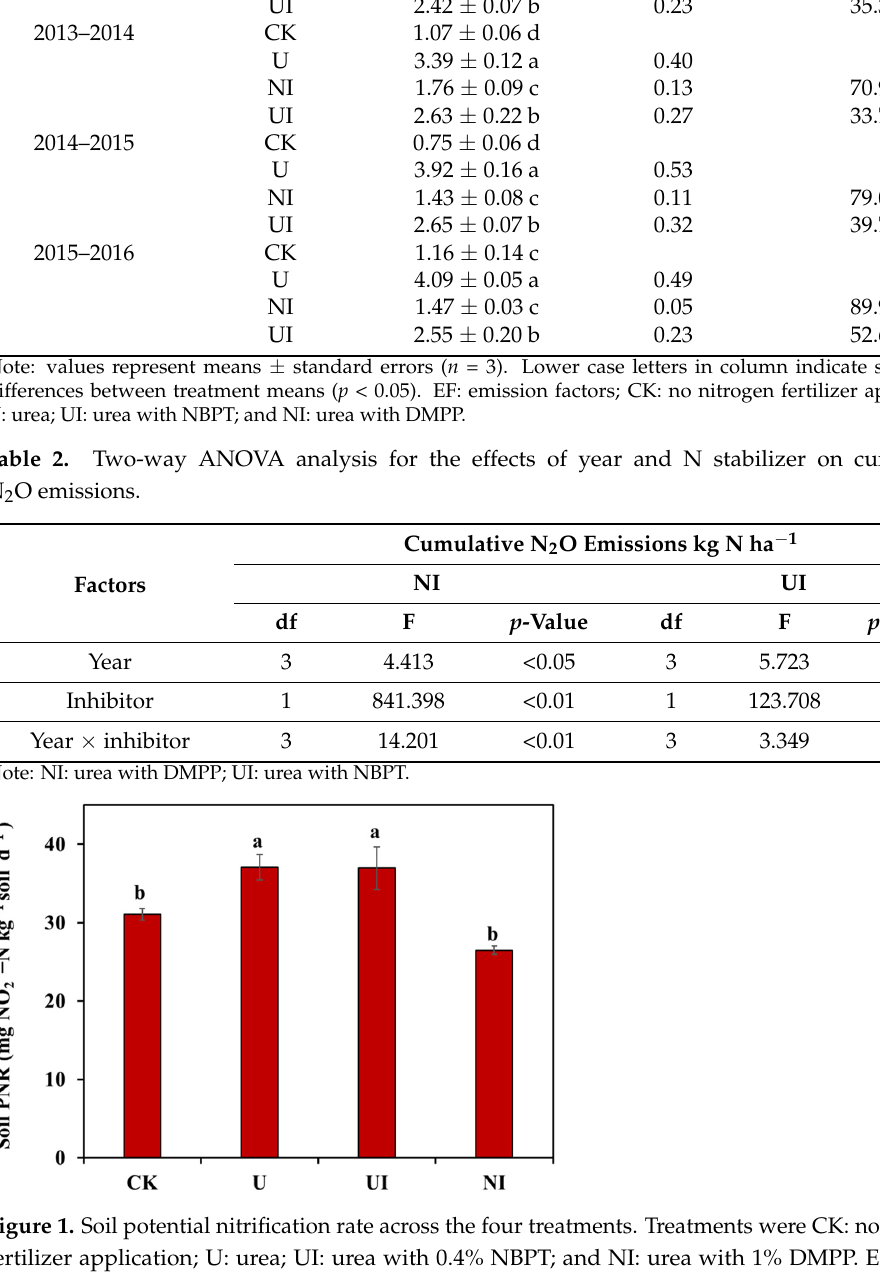
52.6 Note: values represent means ± standard errors ( n = 3). Lower case letters in column indicate signif- icant differences between treatment means ( p < 0.05). EF: emission factors; CK: no nitrogen fertilizer application; U: urea; UI: urea with NBPT; and NI: urea with DMPP. Table 2. Two-way ANOVA analysis for the effects of year and N stabilizer on cumulative N 2 O emis- sions. Factors